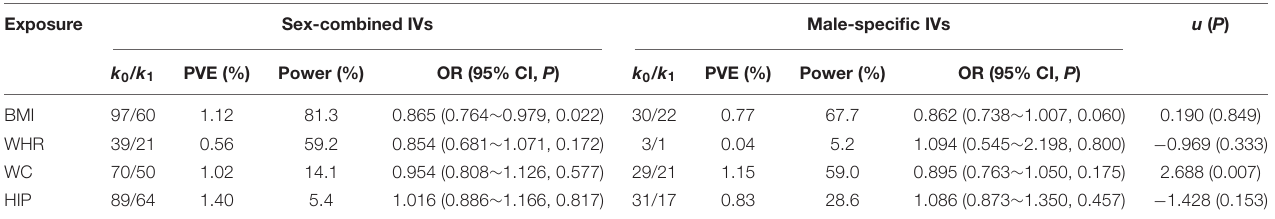
TABLE 4 | Association of anthropometric trait with the risk of prostate cancer using sex-combined and male-specific instruments.